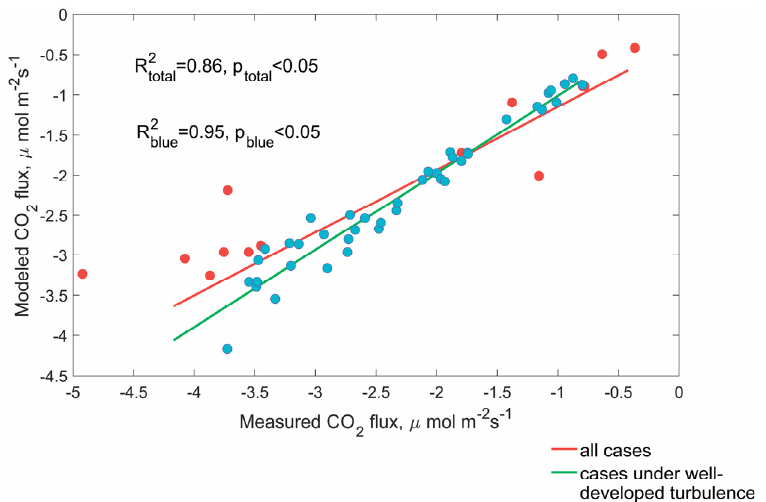
Figure 8. Comparisons of vertical CO 2 fluxes simulated by 3D model and measured by the eddy covariance technique for summer 2016. Blue points show the cases of flux measurements under well-developed turbulence and air temperatures below 28 °C. Red points show measured fluxes under friction velocity lower than 0.05 m s − 1 or in the case of air temperatures, above 28 °C. The red line is the linear regression for all cases (R 2 = 0.86, p < 0.05). The green line is the linear regression for the blue points (R 2 = 0.95, p < 0.05).